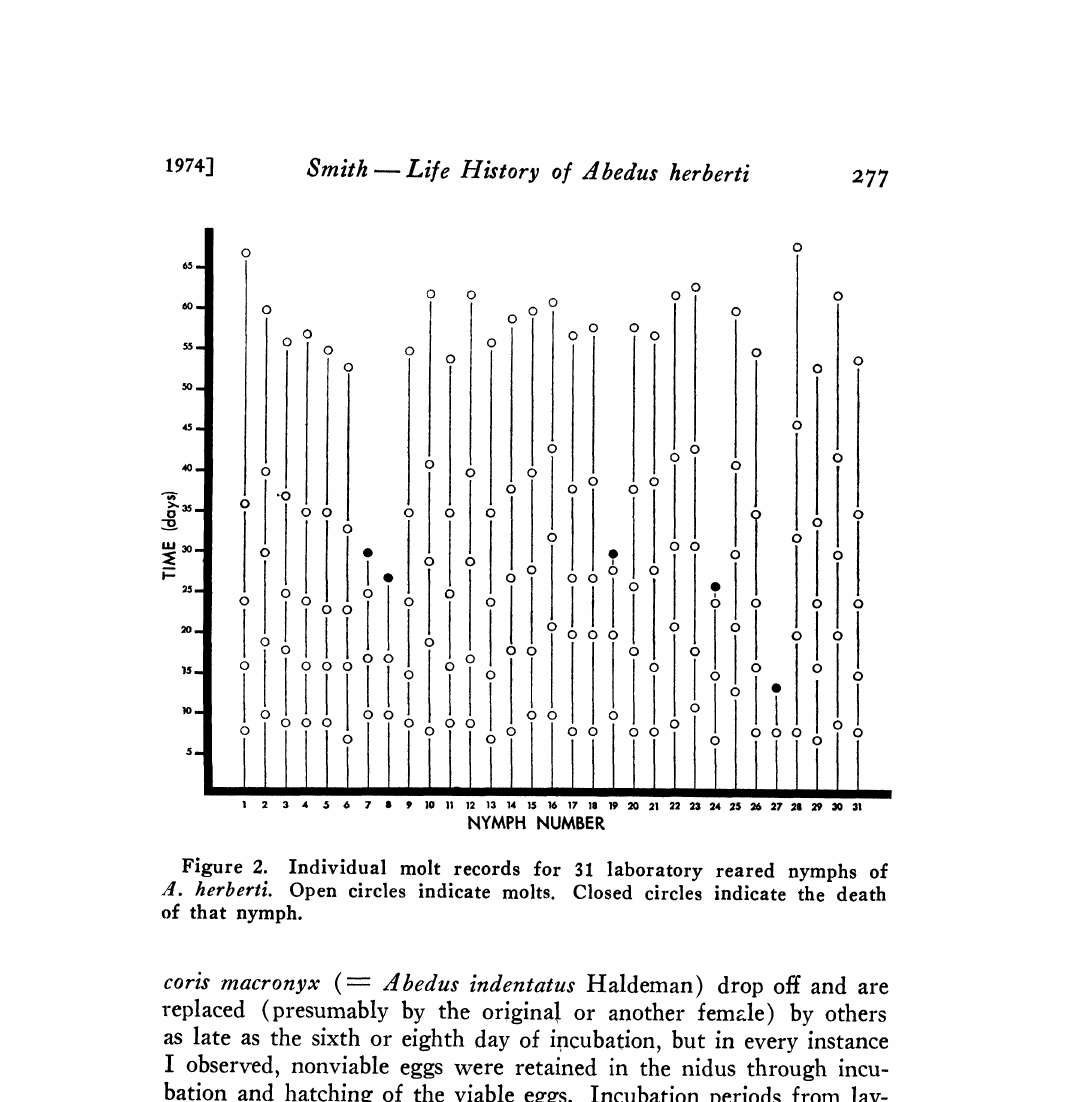
Figure 2. Individual molt records for 31 laboratory reared nymphs of A. herberti. Open circles indicate molts. Closed circles indicate the death that